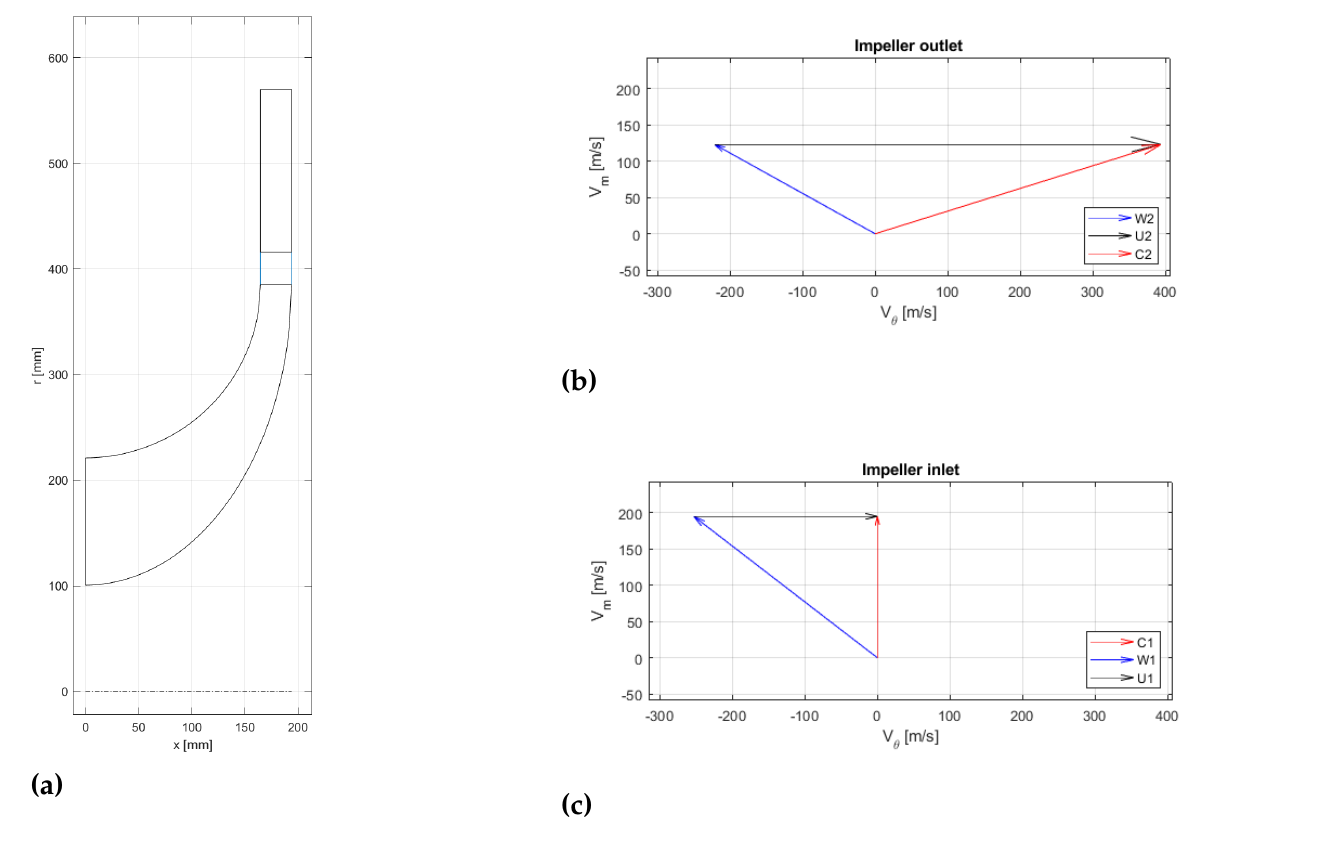
Table 4. Centrifugal compressor design output Z rt specifies the overall number of impeller main and splitter blades Parameter